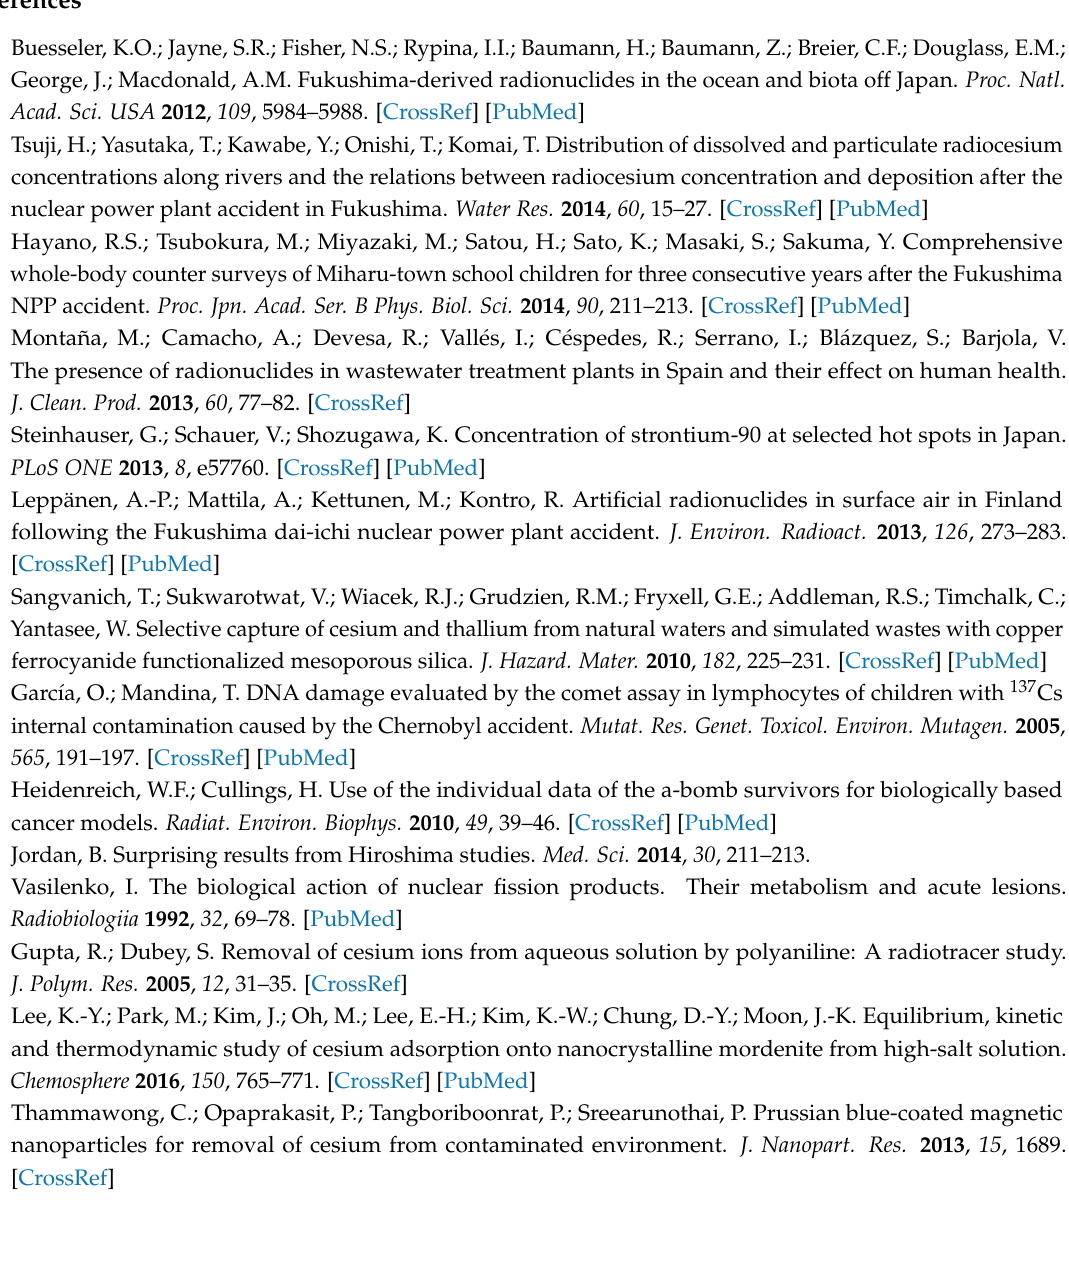
Figure S1: (a–c) TEM images of Fe3O4 nanoparticles, Figure S2: (a) TEM image of MPB and (b) magnified image. (c) TEM image of HPB and (d) magnified image, Figure S3: XRD patterns of Fe3O4